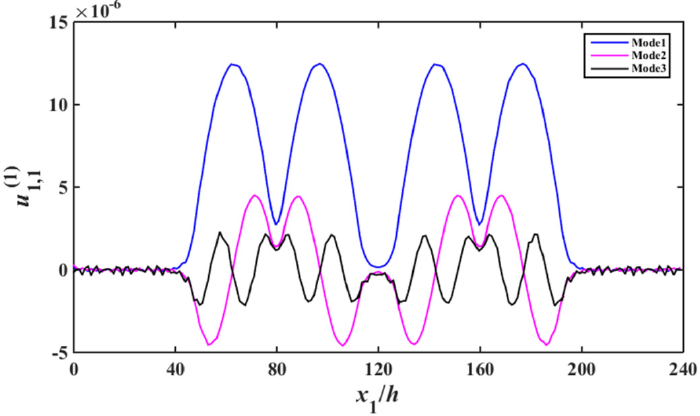
( ) 1 u ). ( 1 ) ( ) 1 ). 1,1 u ). 1,1 1,1